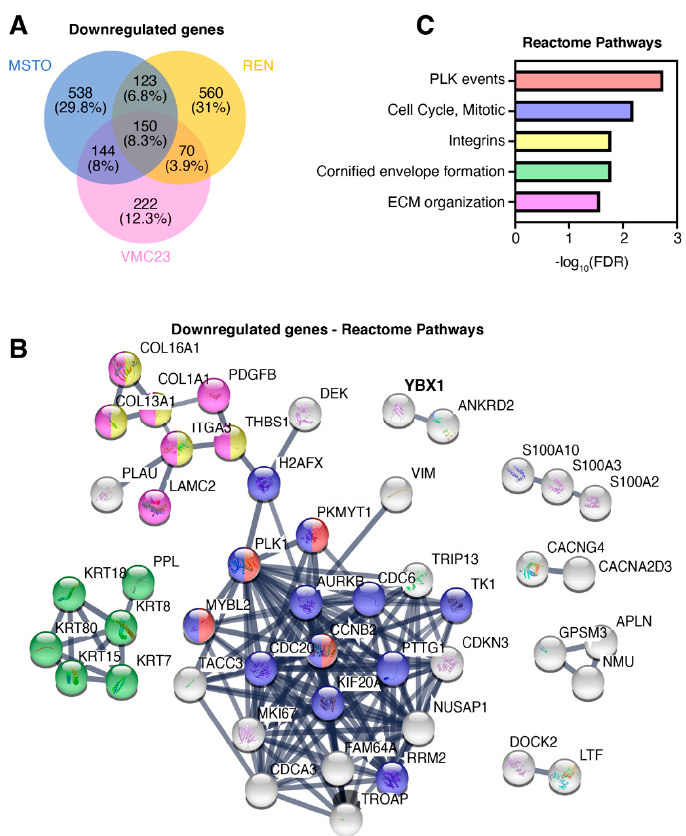
Figure 5. Downregulated genes common to all three cell lines are associated with the mitotic cell cycle. ( A ) Venn diagram of all significantly downregulated genes (log 2 (fold change) < − 2; q -value (FDR) < 0.001) in each cell line, displayed as number of genes (percent of total genes across three cell lines). ( B ) STRING-DB Reactome Pathway analysis of common downregulated human genes ( n = 150) across all three cell lines. Network edges are displayed as ‘confidence’ and disconnected nodes are hidden. Genes highlighted in colour correspond to ( C ) the top five most significant Reactome pathways. Significance is shown as − log 10